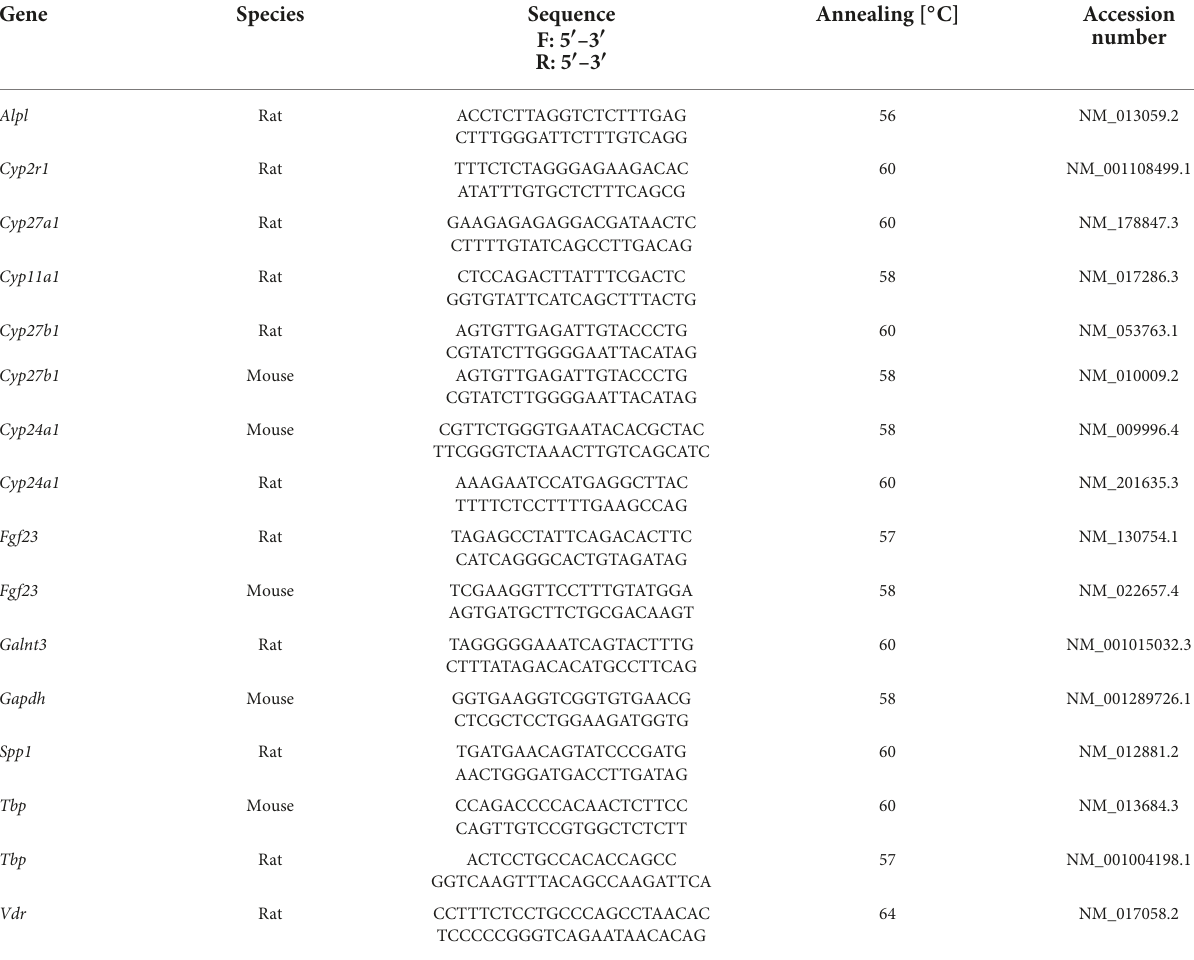
TABLE 1 Primers used for the analysis of the relative mRNA abundance of genes. Gene